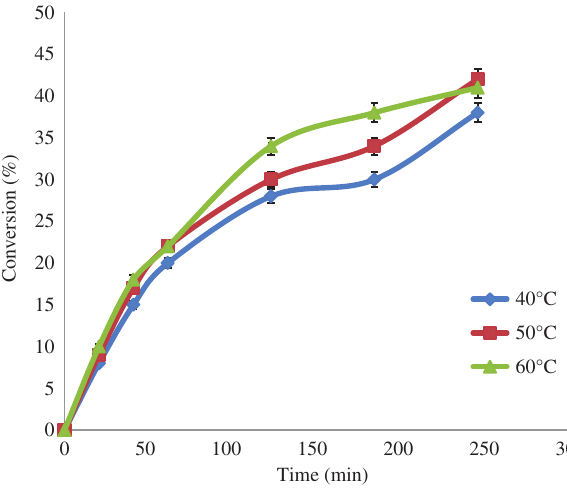
Figure 2: Effect of temperature on conversion at hexanol:triacetin ratio 1:1, hexane-3 ml, enzyme loading 1% (w/v), agitation speed 100 rpm, power 100 W, duty cycle 80% and frequency 25